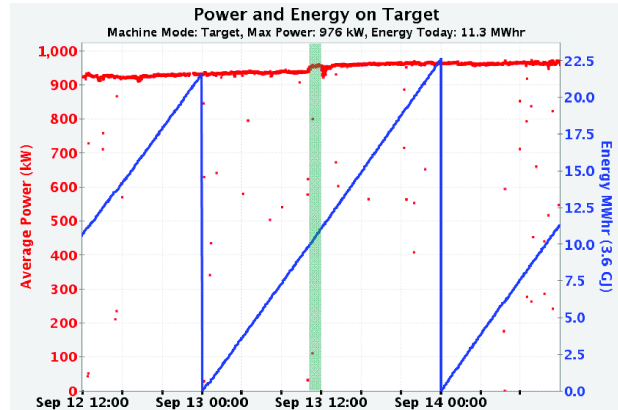
FIG. 8. A snapshot of SNS beam status around September 13, 2012. The time window for the laser wire based simultaneous profile measurement is indicated with the shadowed